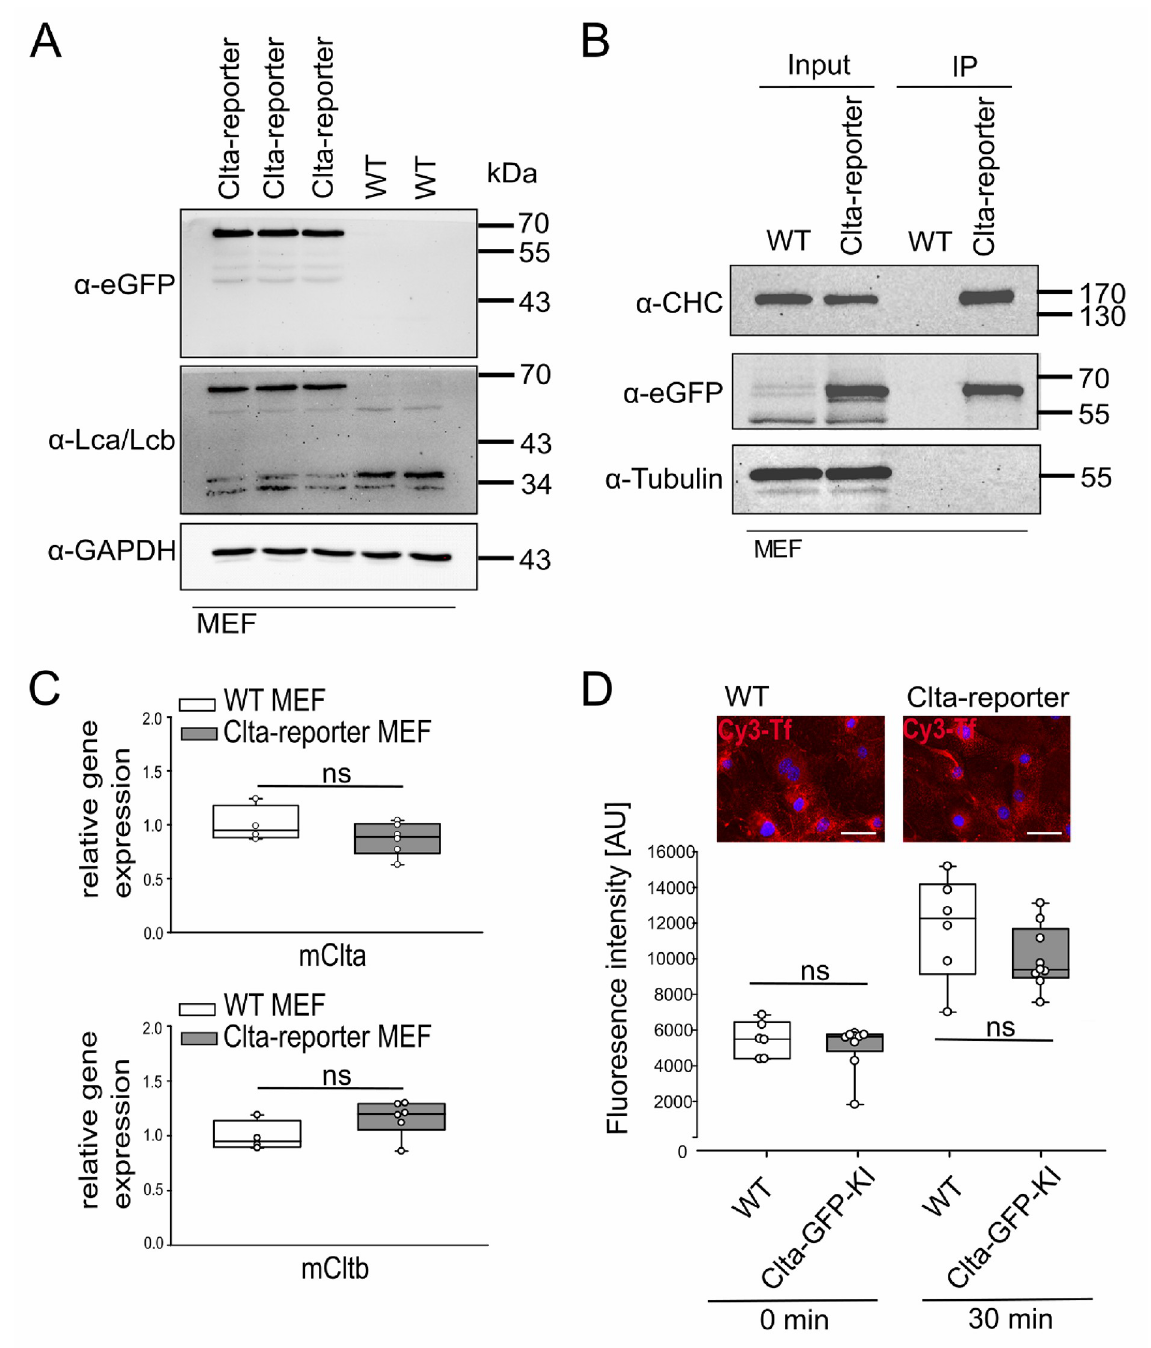
Fig 4. Clta-eGFP in primary MEFs. ( A ) Western blot of three Clta-reporter MEF and two WT MEF cell lines. Clta-eGFP fusion protein is detected using anti-eGFP and anti-Lc antibodies. On each lane 20 μ g of total protein were loaded. ( B ) Co-IP of CHC and Clta-eGFP fusion protein in MEFs. ( C ) qPCR of Clta and Cltb in MEFs. No significant changes were observed in Clta-reporter and WT MEFs. WT: n = 4; Clta- reporter n = 6 (students t-test). ( D ) Cy3-Tf uptake in Clta-reporter and WT MEFs: no significant changes in the uptake of Cy3-Tf were detected between WT and Clta-reporter MEFs at 0 min and 30 min (students t-test). WT: n = 6; Clta-reporter n = 9; Scale bar: 50 μ m.